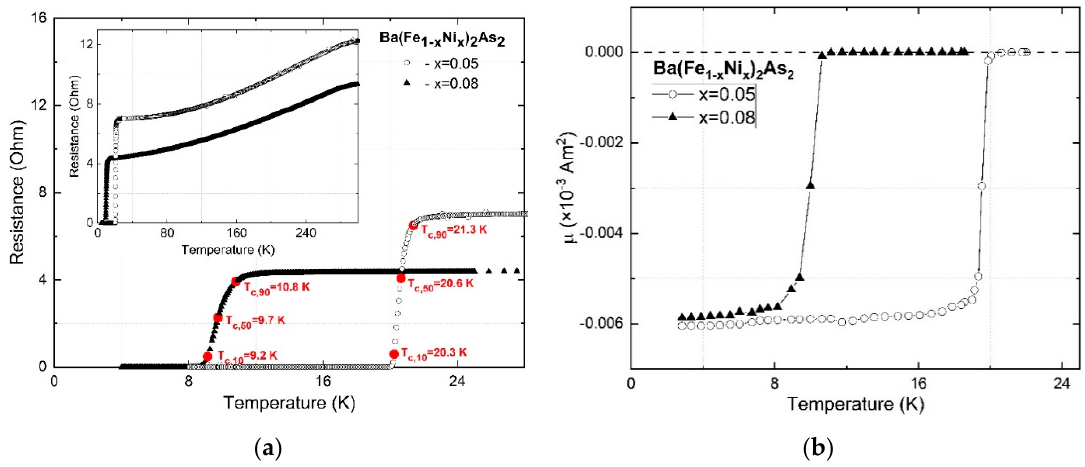
Figure 2. Temperature dependence of the resistance without a magnetic field ( a ) as well as = 0.05 and susceptibility ( b ) for Ba(Fe 1 − x Ni x ) 2 As 2 films with x = 0.05 and 0.08. ( b ) for Ba(Fe 1 − x Ni x ) 2 As 2 films with x